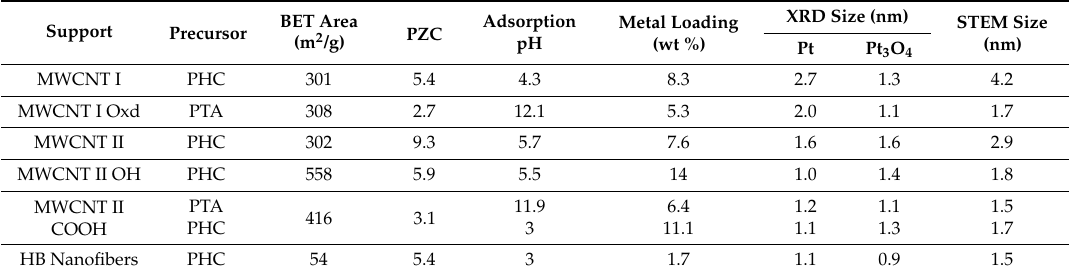
Table 2. Summary of supports, precursors, synthesis pH and particle,